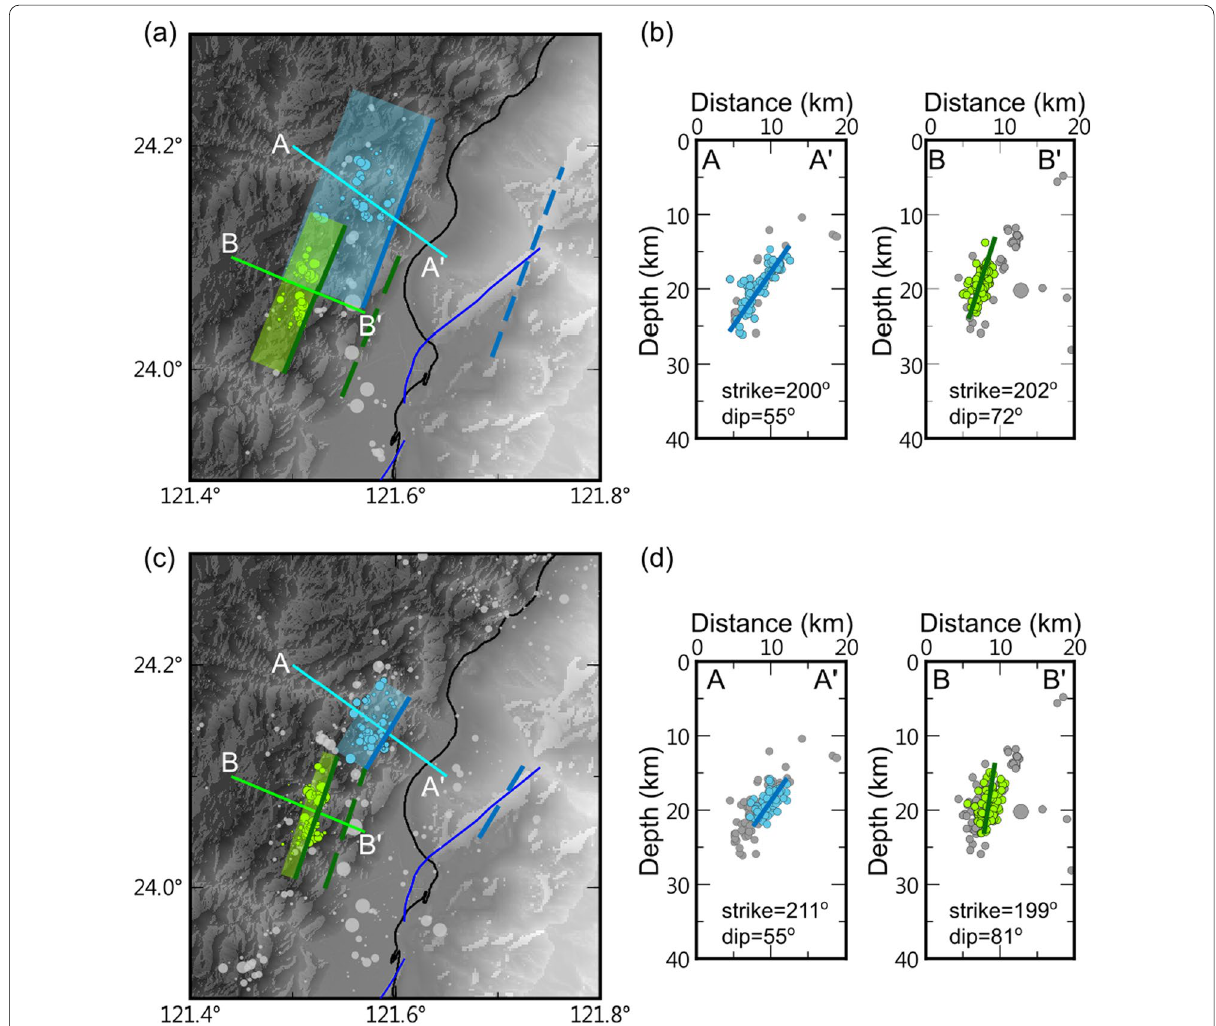
Fig. 5 DBSCAN and PCA control test for 2019 FMA sequence ( a , b ) and CWB catalog ( c , d ): a , c DBSCAN and PCA results with noise events (gray), cluster events (colored) and corresponding PCA planes (rectangles) of the 2019 FMA sequence (Huang and Wu 2022) and CWB catalog (M L April–June, 2019); b , d profiles of PCA plane projections (thick lines), clustered (colored) and unclusterd (gray) events along cross‑sections of northern and southern clusters shown in ( a ) or ( c